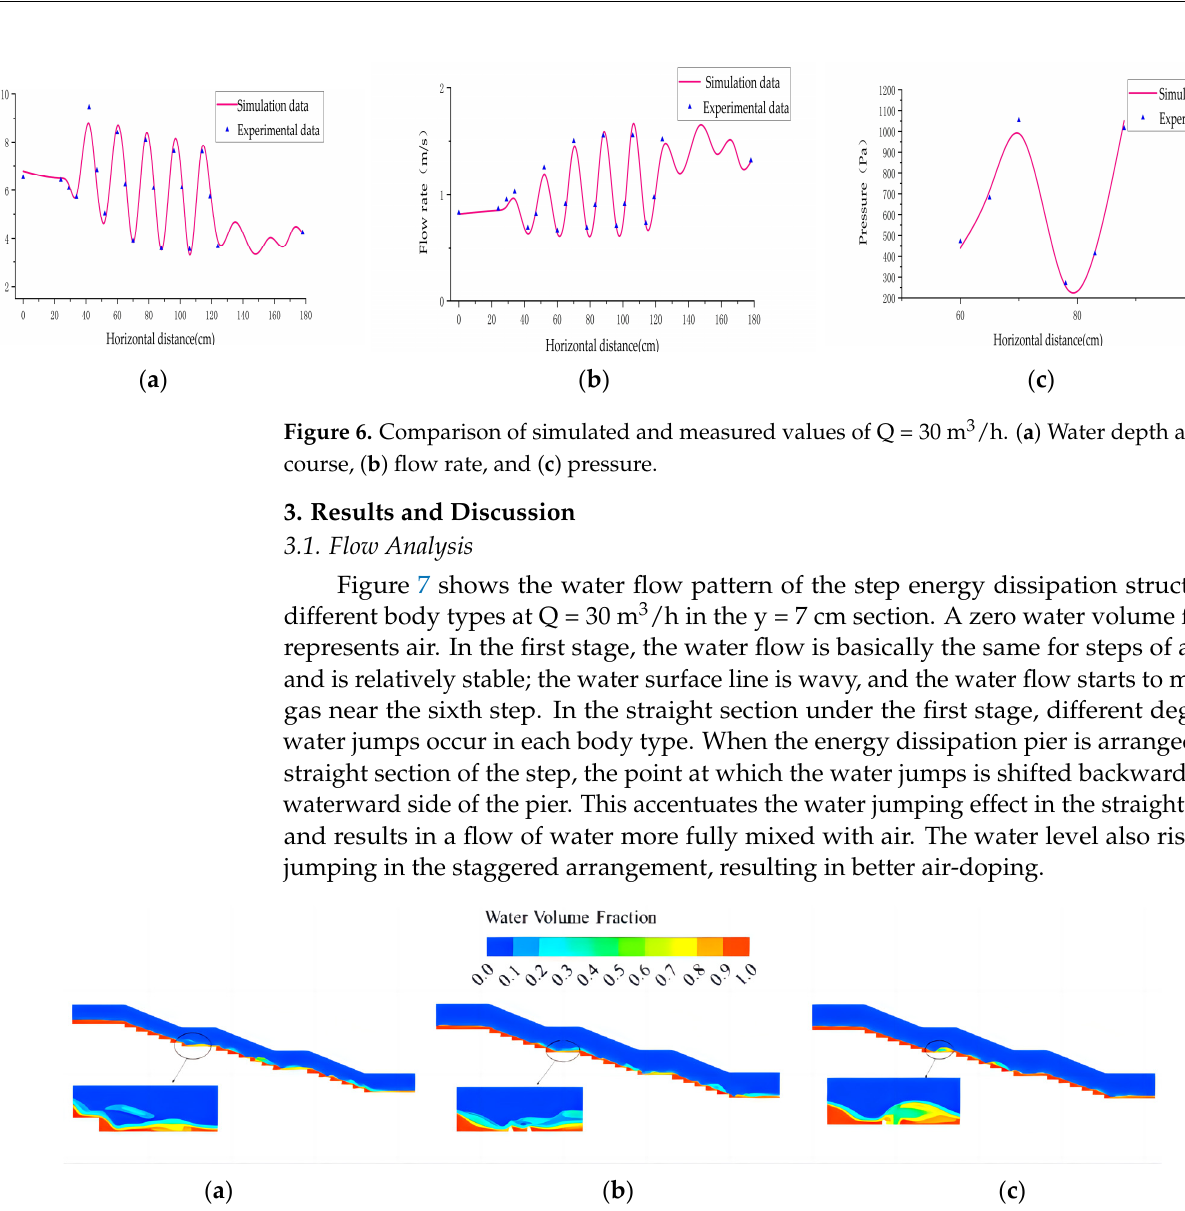
Figure 7. Flow pattern of each body type step water flow at Q = 30 m 3 /h. ( a ) Traditional steps, ( b ) double-row arrangement, and ( c ) staggered arrangement.